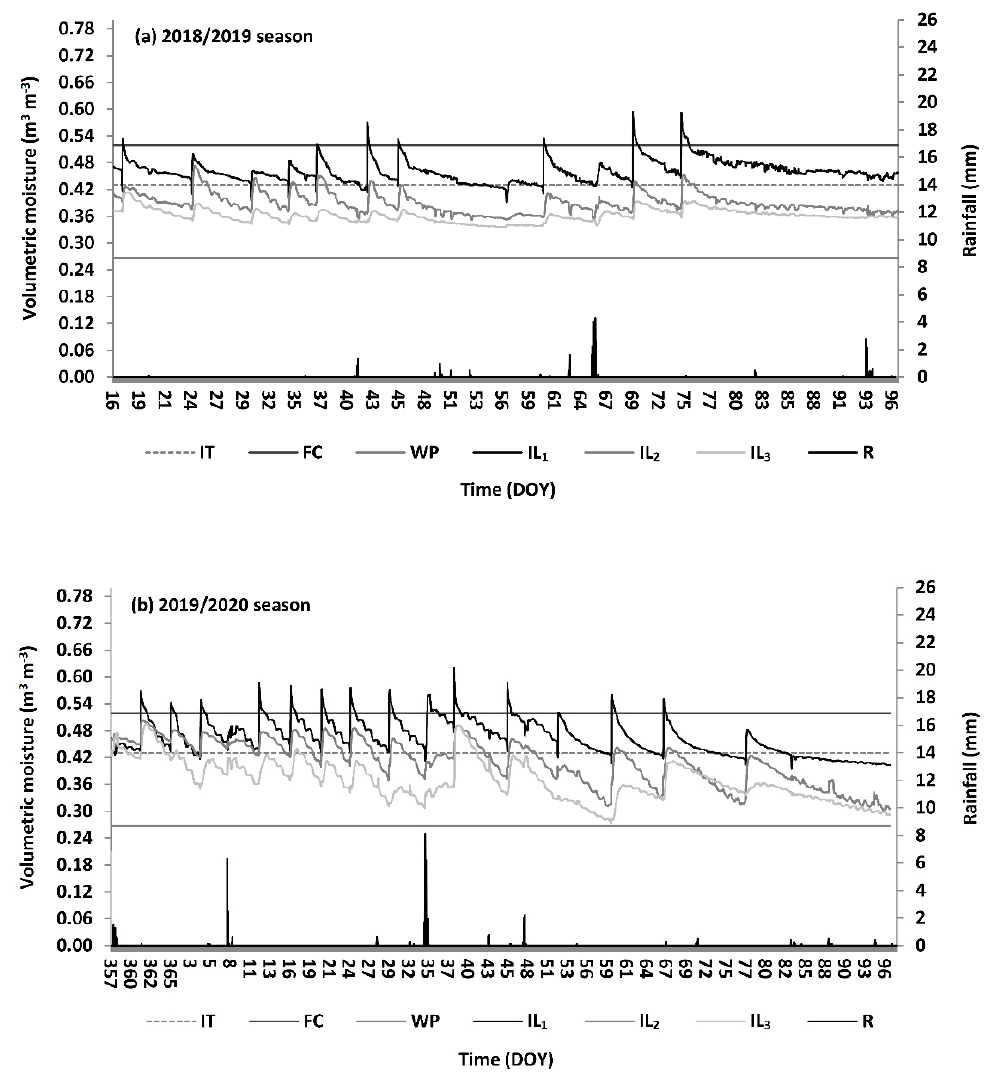
Figure 3. Variation of volumetric soil water content and rainfall measured values for the two evaluated seasons 2018/2019 ( a ) and 2019/2020 ( b ). The irrigation level (IL) was IL 1 : Full irrigation, IL 2 : 75% of IL 1 , and IL 3 : 60% of IL 1 . IT, R, FC, and WP are irrigation threshold, rainfall, and soil water content at field capacity and permanent wilting point.